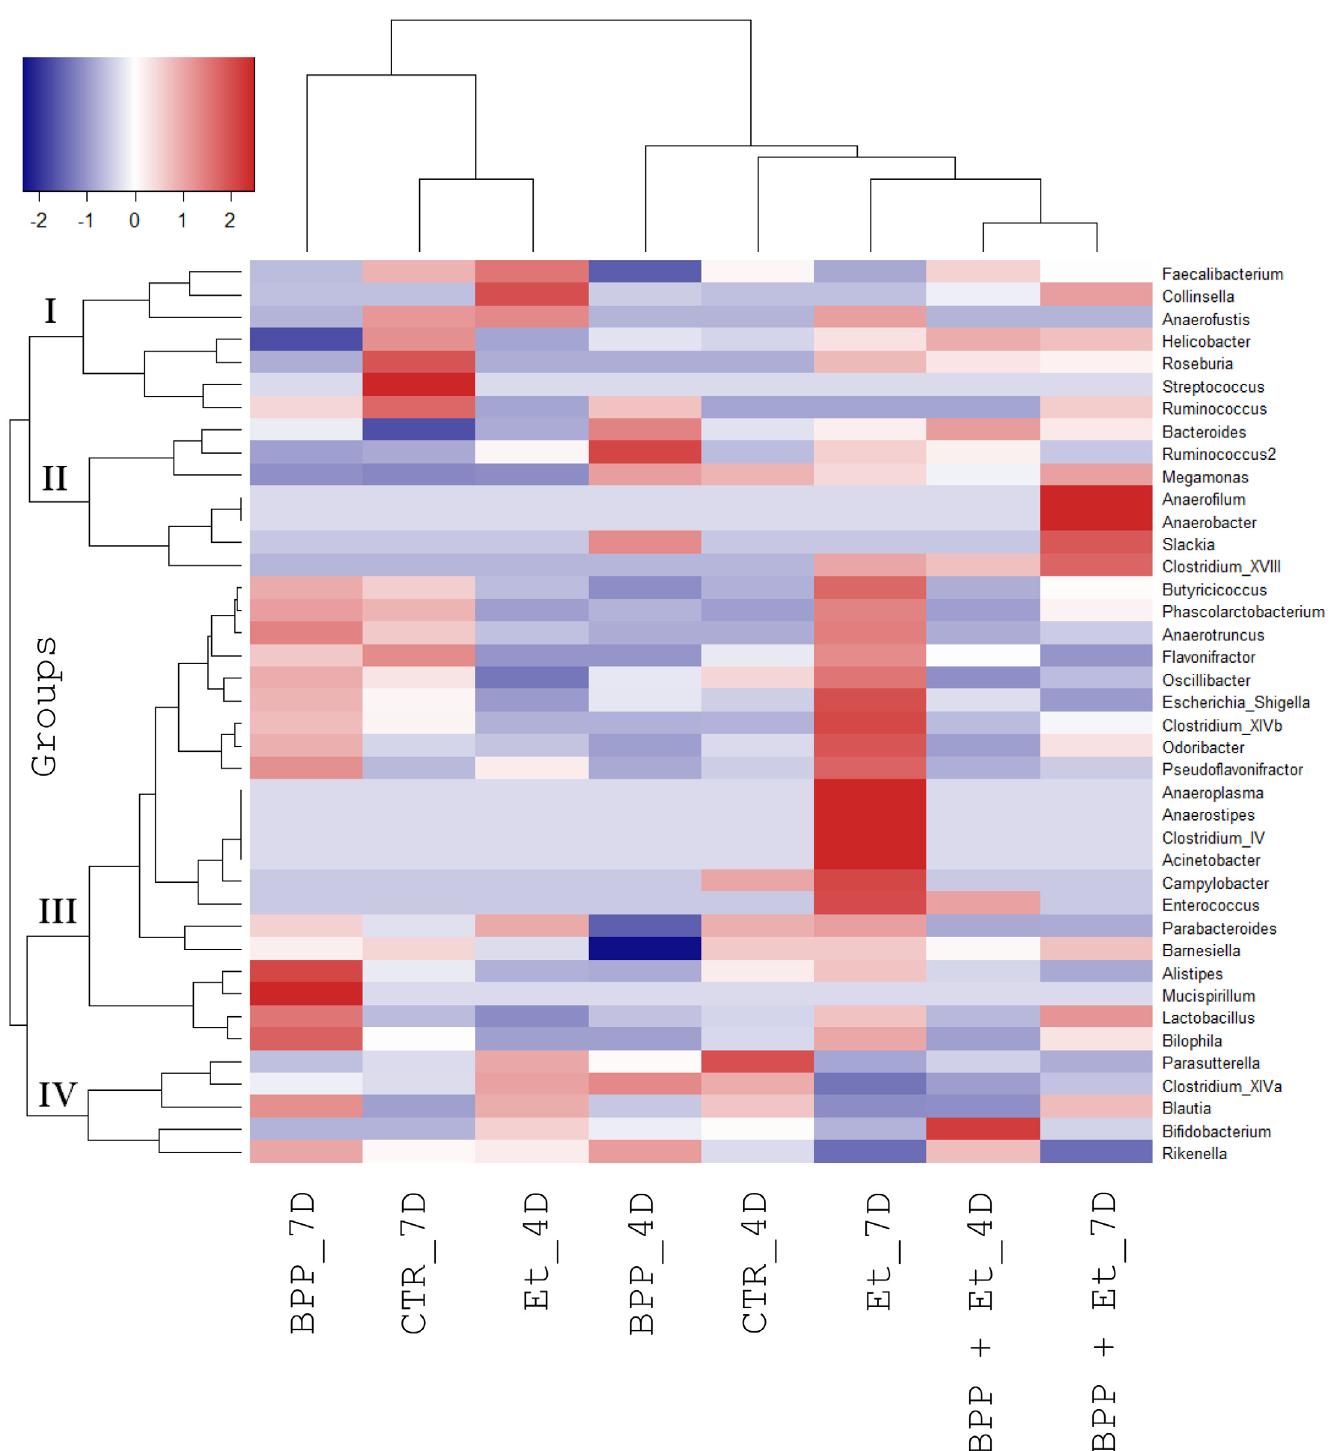
Fig 5. Clustering analysis of the compositions of the bacterial genera in the guts of chickens. Clustering analysis of the bacterial genera in chicken guts ( Fig 2) was performed to correlate the proportion of the bacterial community with their genera.